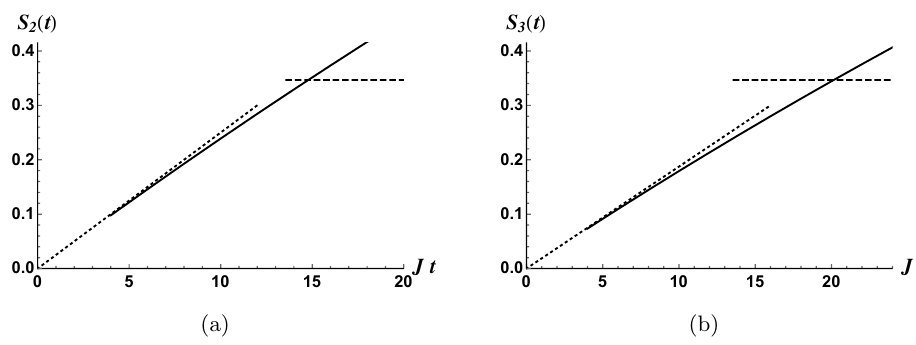
Figure 3 . (a) The second R(cid:19)enyi entropy and (b) the third R(cid:19)enyi entropy per Majorana fermion. The solid line is from the replica diagonal solution, which grows linearly. The dashed line is from the replica non-diagonal solution that takes over after Page time. The value of the dashed line is 1 log 2. The dotted line plots the (cid:12)rst line in (2.35) for 2